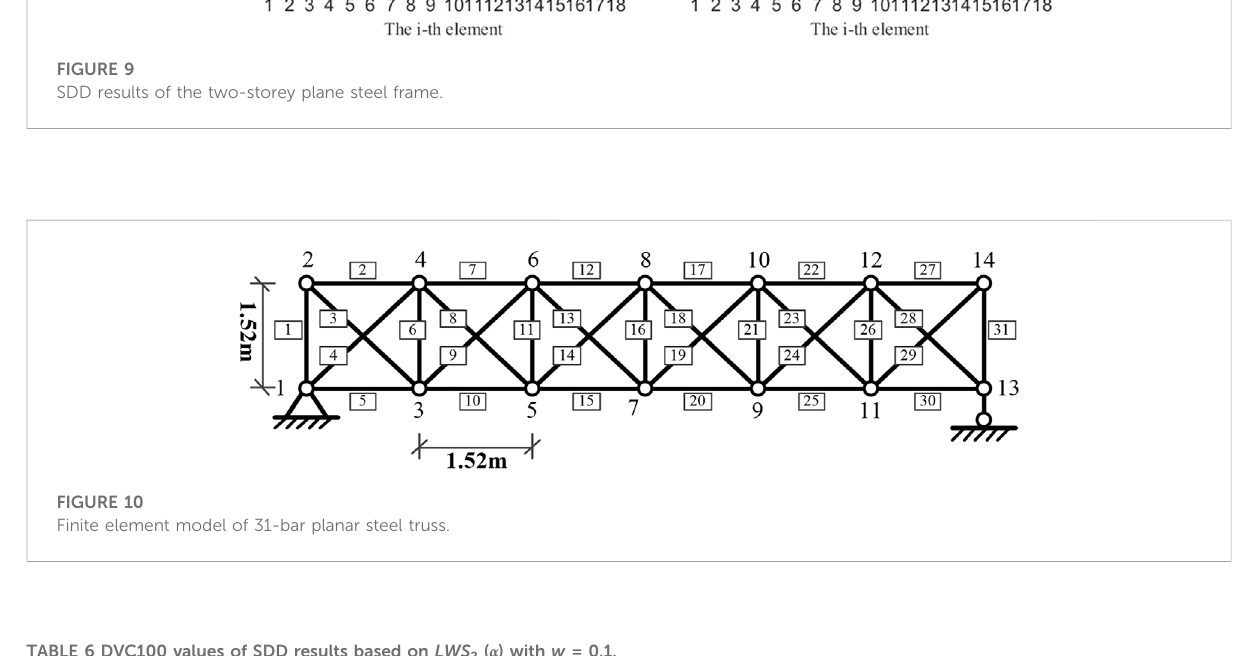
TABLE 6 DVC100 values of SDD results based on LWS 2 ( α ) with w =